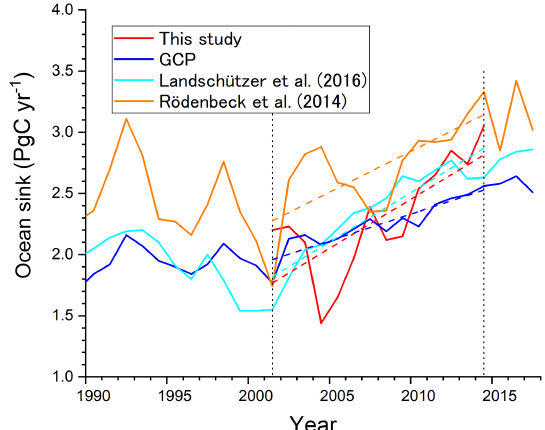
ping methods is about 0.8 PgC yr − 1 per decade (Rödenbeck